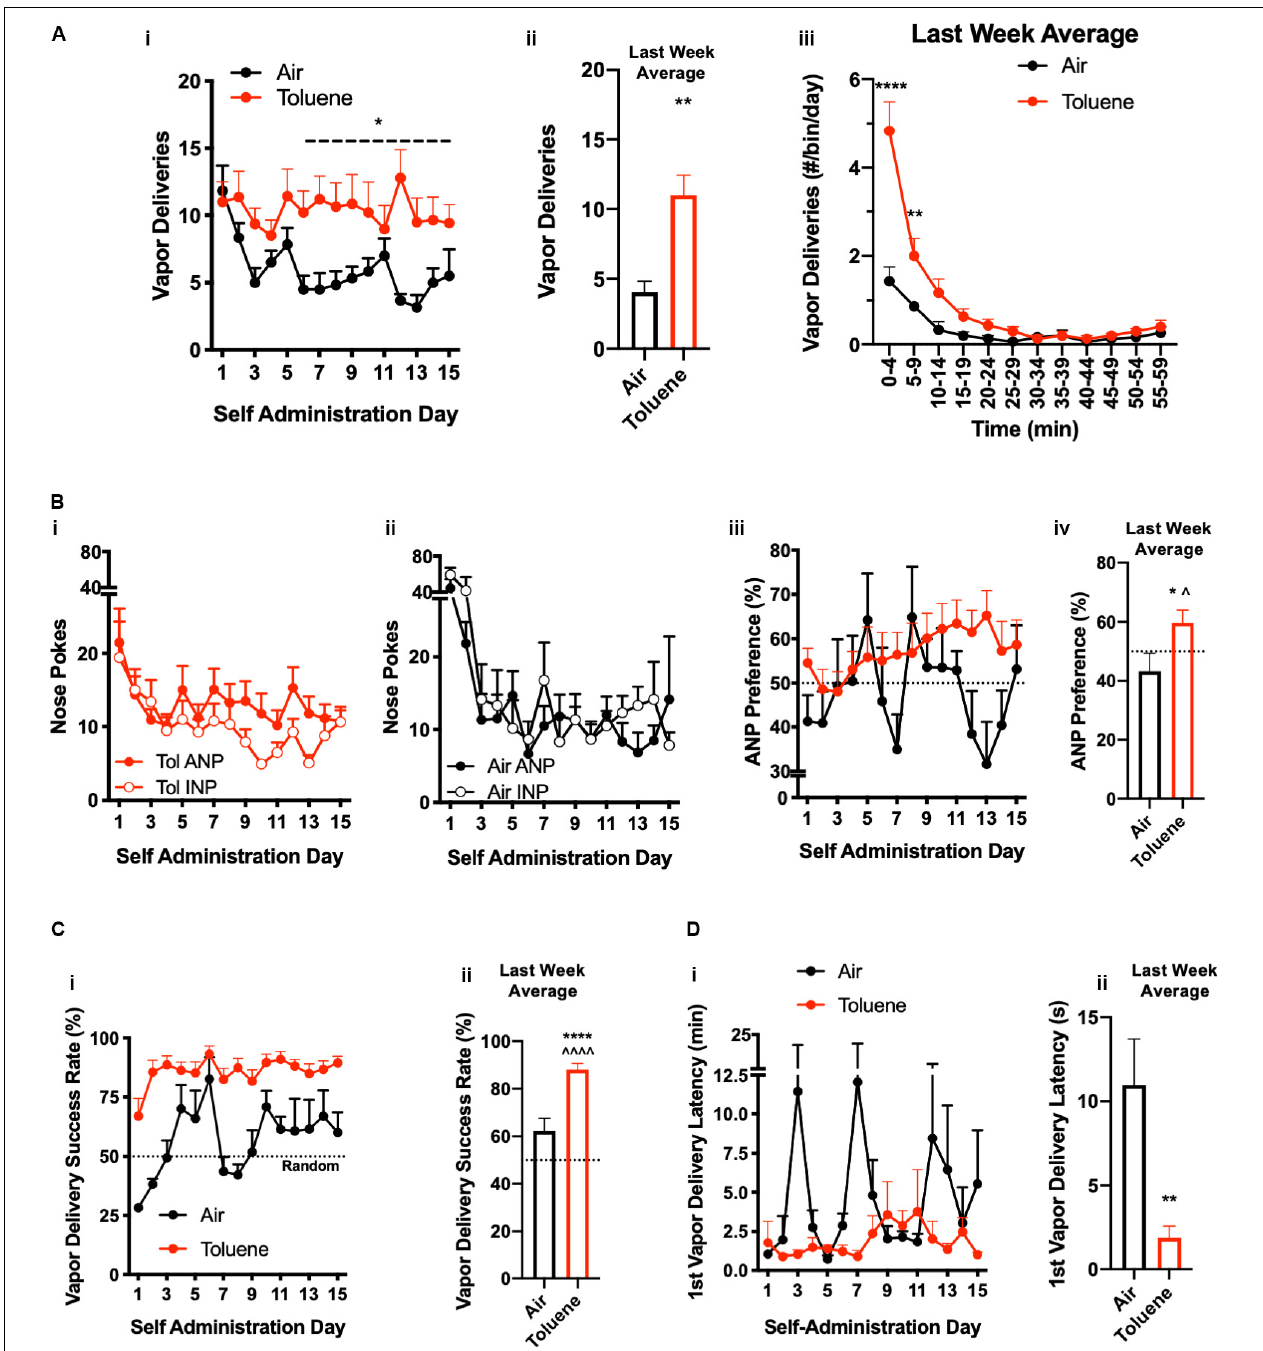
FIGURE 2 | Toluene self-administration. Operant responding for toluene (Tol) vapor or Air across 3 weeks of SA training. (A-i) Number of daily vapor deliveries for Air SA and Tol SA rats; * p < 0.05 Tol vs. Air, two-way repeated measures ANOVA. (A-ii) Summary graph showing last week average vapor deliveries for Air or Tol rats; ** p < 0.01, Tol vs. Air, Student’s t -test. (A-iii) Time course of vapor deliveries during the 1 h session shown in 5 min bins; ** p < 0.01, **** p < 0.0001, Student’s t -test, Tol vs. Air. (B-i) Number of active nose pokes (ANP) and inactive nose pokes (INP) in Tol SA rats. (B-ii) Number of active nose pokes (ANP) and inactive nose pokes (INP) in Air SA rats. ( B-iii) ANP preference (ANPs/total NPs) across 3 weeks of testing (dotted line denotes no preference). (B-iv) Summary graph showing last week average active nose pokes for Air or Tol rats; * p < 0.05, Student’s t -test Tol vs. Air; ˆ p < 0.05, one-sample t -test Tol vs. 50% ANP preference. (C-i) Vapor delivery success rate (vapor deliveries/ANPs) across 3 weeks of testing (dotted line denotes random entry). (C-ii) Summary graph showing last week average vapor delivery success rate for Air or Tol rats; **** p < 0.0001, Student’s t -test Tol vs. Air; ˆˆˆˆ p < 0.0001, one-sample t -test Tol vs. 50% vapor delivery success rate.